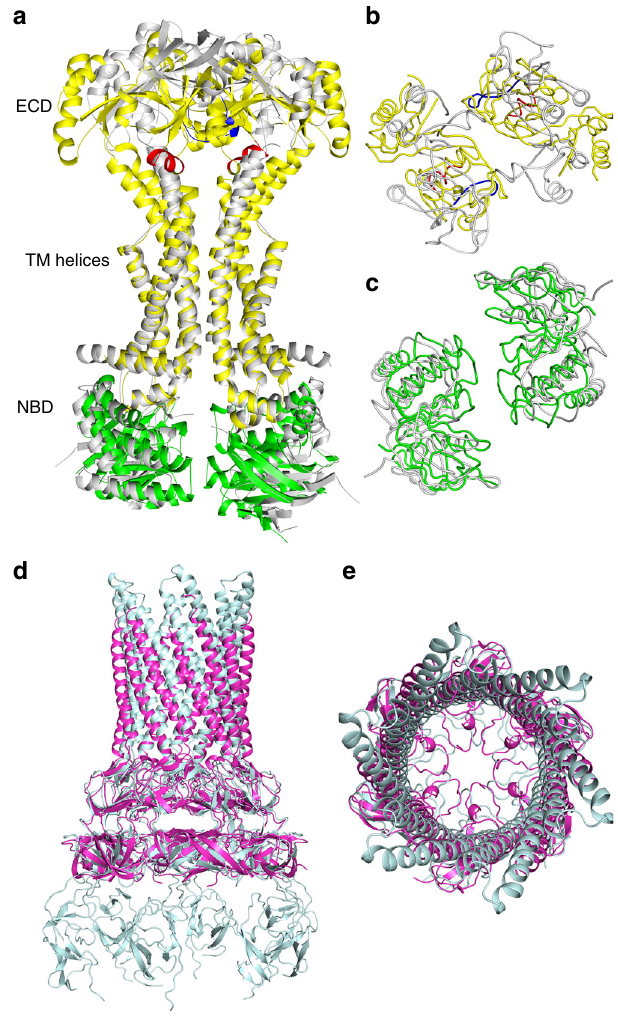
Fig. 4 Superposition of Spr0694 – 0695 and Spr0693 to MacB and MacA, respectively. a Comparison of the overall structures of Spr0694 – 0695 and MacB, by superimposing the TM helices in the intracellular membrane face. Spr0694 and Spr0695 are shown in green and yellow, respectively, whereas MacB is shown in gray. The helix α 6 and its counterpart in MacB are colored in red and blue, respectively. b Top and c bottom view of a . d Side and e top view of the superimposed Spr0693 (purple) and